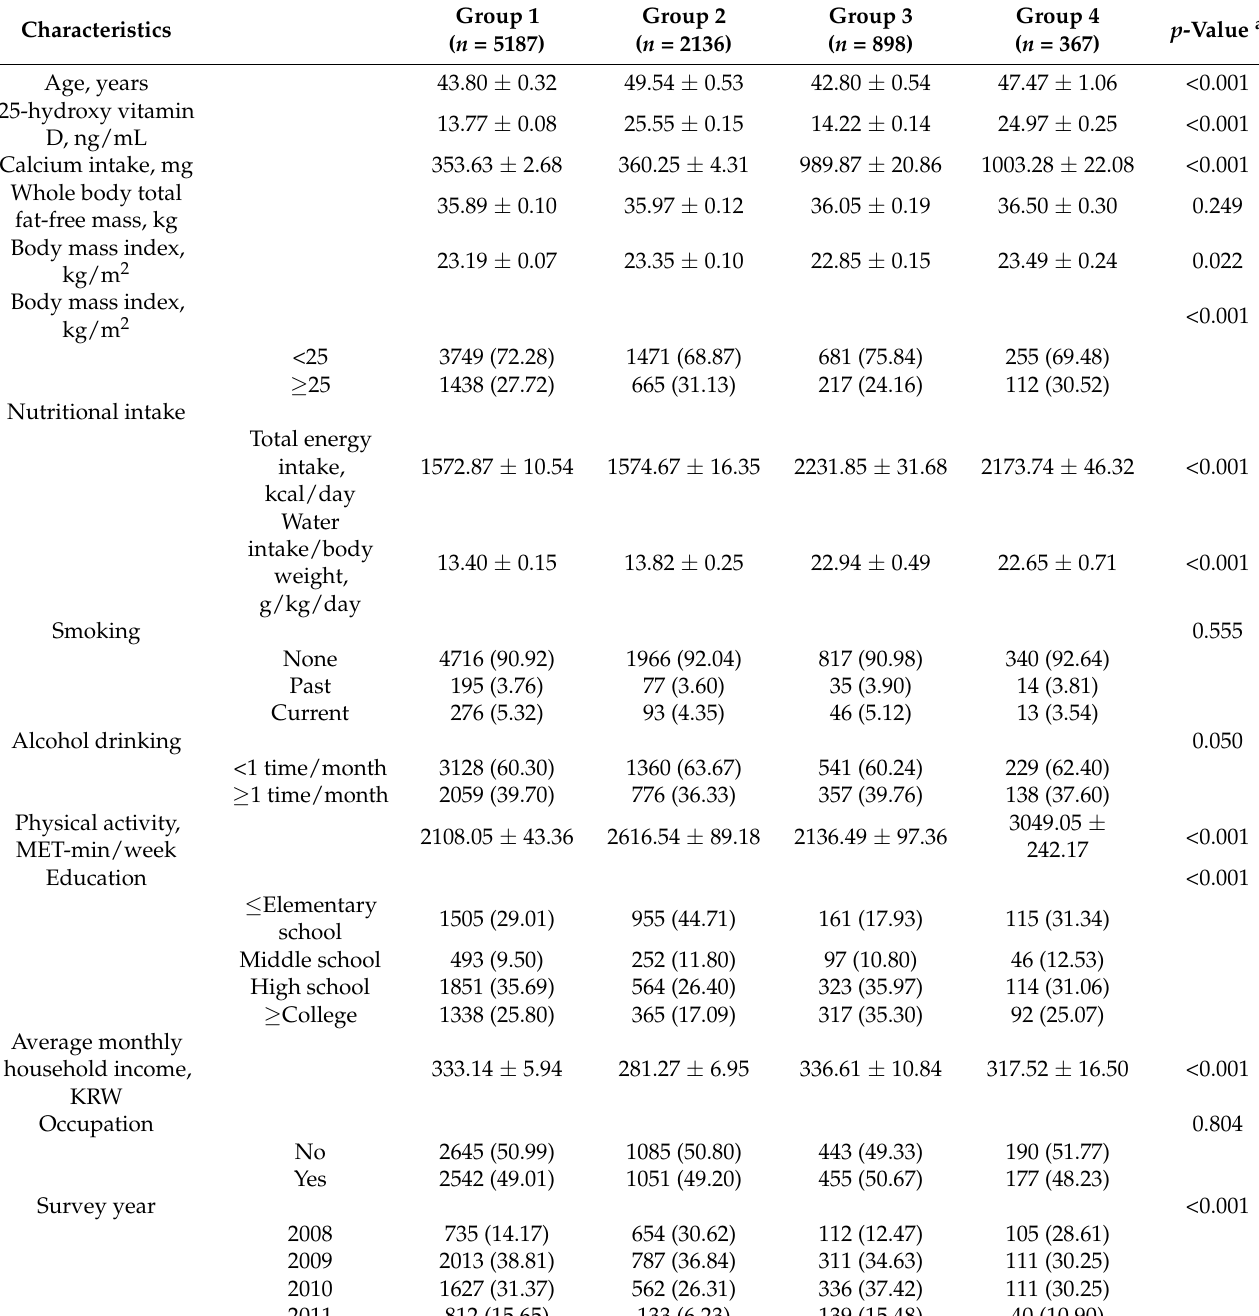
Table 3. Comparison of basic characteristics by group in